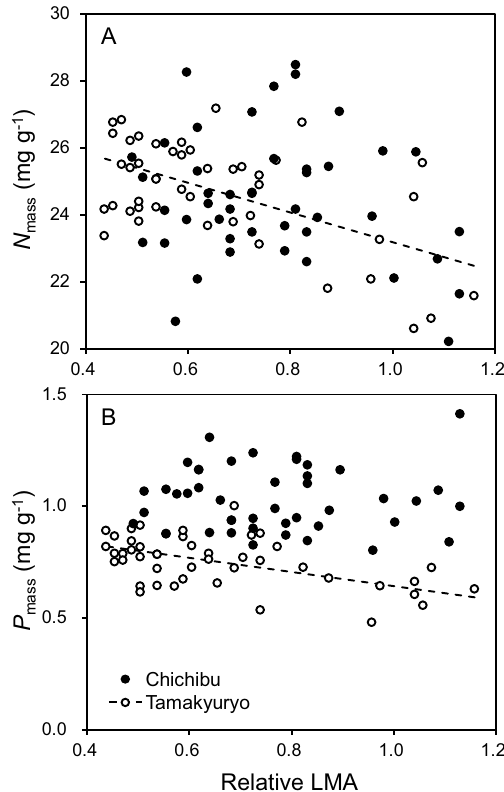
Figure 3. Concentration of ( a ) nitrogen and ( b ) phosphorus per unit leaf dry mass ( N mass and P mass , respectively) as a function of relative LMA of Q. serrata grown in FM Tamakyuryo in July 2018 (while circle) and FM Chichibu in August 2018 (black circle) (n = 45). Dotted line indicates regression line of FM Tamakyuryo. Regression line was drawn when there was a significant effect of relative